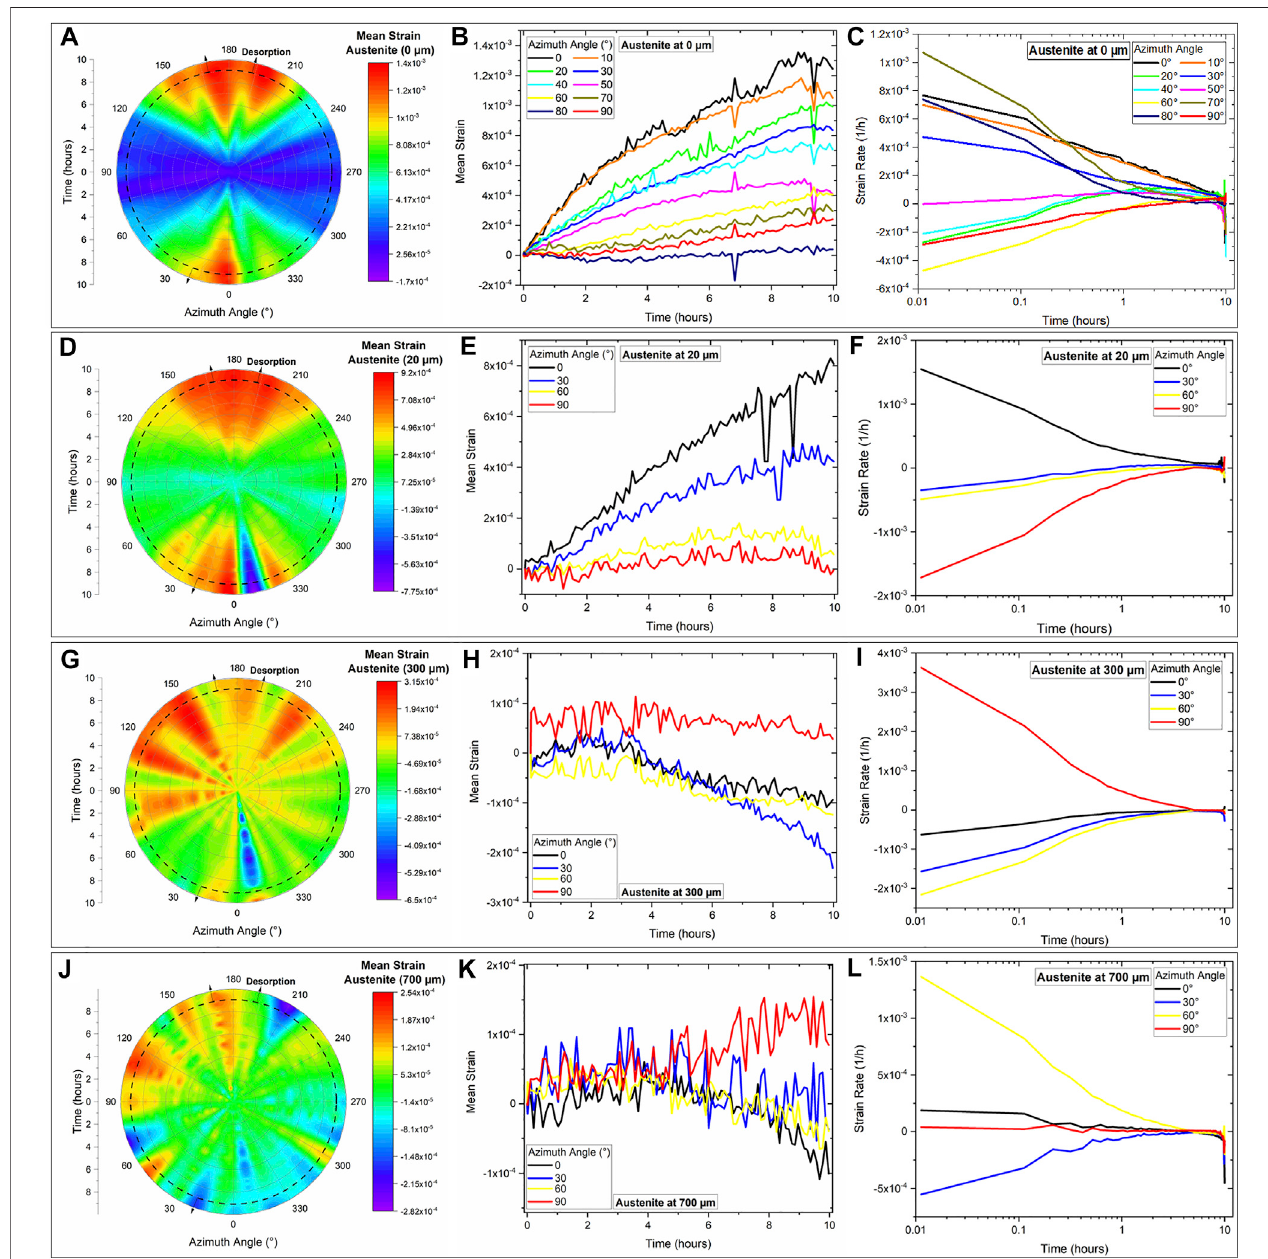
FIGURE 7 | 3-D polar strain plots (A,D,G,J) with extracted strain vs. time (B,E,H,K) and temporal derivative of strain (strain rate) vs. time (C,F,I,L) plots of the austenite phase, showingthelattice straindevelopmentasafunctionoftimeofhydrogen charging atdifferentdepthregions: (A – C) atthesurface, (D – F) at 20 µm, (G – I) 300 µm,and (J – L) 700 µmbelowthesurface.Theradialaxisshowsthetime(thecentreist (cid:1) 0),andtheangularaxisistheazimuthangle.Thepro fi lesin (B,E,H,K) show the strain evolution over selected azimuth angles. Note that the data along 350 ° is less reliable due to the beam-stop mount, which was masked out for data integration but might affect the